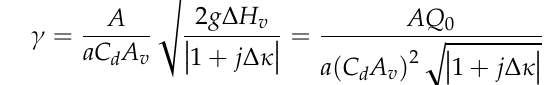
Figure 9. Impact of the VSI condition on the resonances and anti-resonances of the upstream and downstream pressure fluctuations with a steady friction model ( κ = 0.04